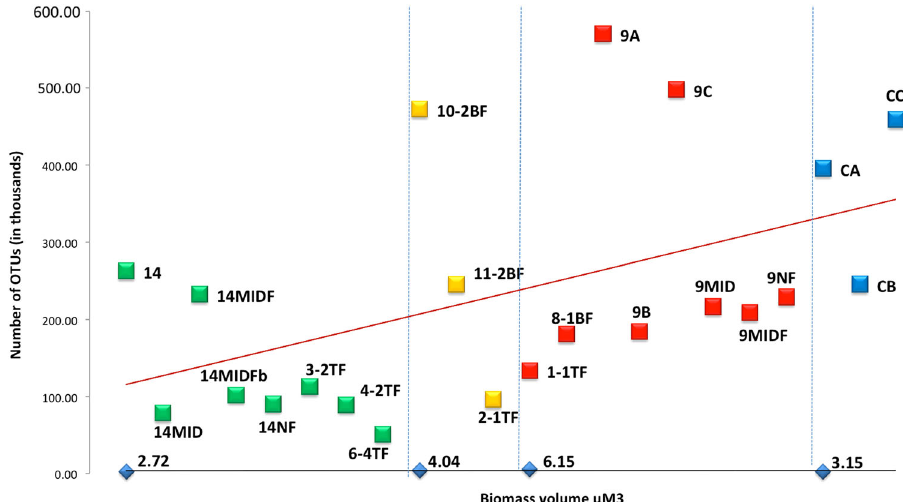
Fig. 3 Linear regression graph of the total number of OTUs sequenced from the clean ( green ), moderately fouled ( yellow ), severely fouled ( red ), and unused control RO membranes ( blue ), against the average bio fi lm-biomass of the corresponding groups of membranes. The vertical blue dotted lines separate the different classi fi cations of membranes